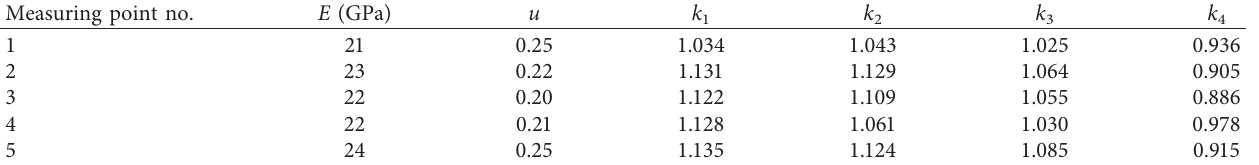
Table 5: The values of elastic modulus ( E ), Poisson’s ratio ( υ ), and k coefficient of each measuring point. Measuring point